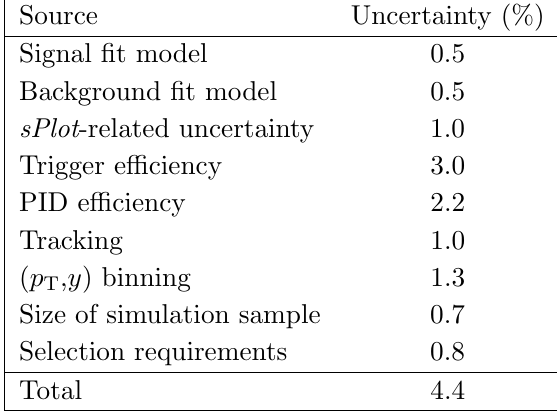
Table 1 . Systematic uncertainties relative to the central value of the ratio R p(cid:30)